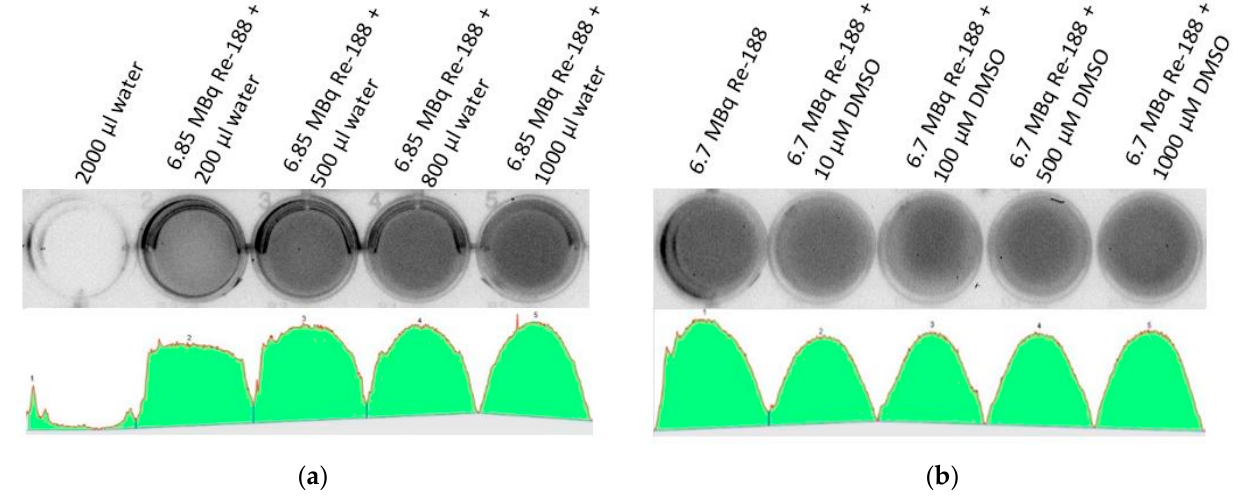
Figure 6. Light intensity of different setups of Re-188 and DMSO as preliminary investigations. The spectra show the detected light intensity in arbitrary units, thus, they are not quantifiable. ( a ) The first well did not contain radioactivity (2000 µL distilled water) and did not consequently show light intensity. The other wells contained a nearly constant amount of Re-188 (approximately 6.85 MBq) and varying volumes of water (f.l.t.r. 200, 500, 800, and 1000 µL). More light intensity was seen for larger water volumes. The spectrum showed that there was no linear behavior between the volume of the medium and the light intensity. However, a saturation was reached for a volume large enough to produce a 1 cm water column (depends on size of well). Measured light intensity: 7 Mio (background, no activity), 22 Mio, 27 Mio, 28 Mio, 29 Mio integral light volume intensity in arbitrary units for each well. ( b ) All wells contained a constant amount of Re-188 (approximately 6.7 MBq), varying amounts of DMSO, and additional water to reach a constant volume of 2000 µL. From left to right, an increasing amount of DMSO was added to the wells (0, 10, 100, 500, and 1000 µM). The same light intensity was seen for every DMSO concentration, since it is not photo-activated by Re-188. Measured light intensity f.l.t.r.: 28 Mio, 26 Mio, 26 Mio, 27 Mio, 27 Mio integral light volume inten- sity in arbitrary units for each well.